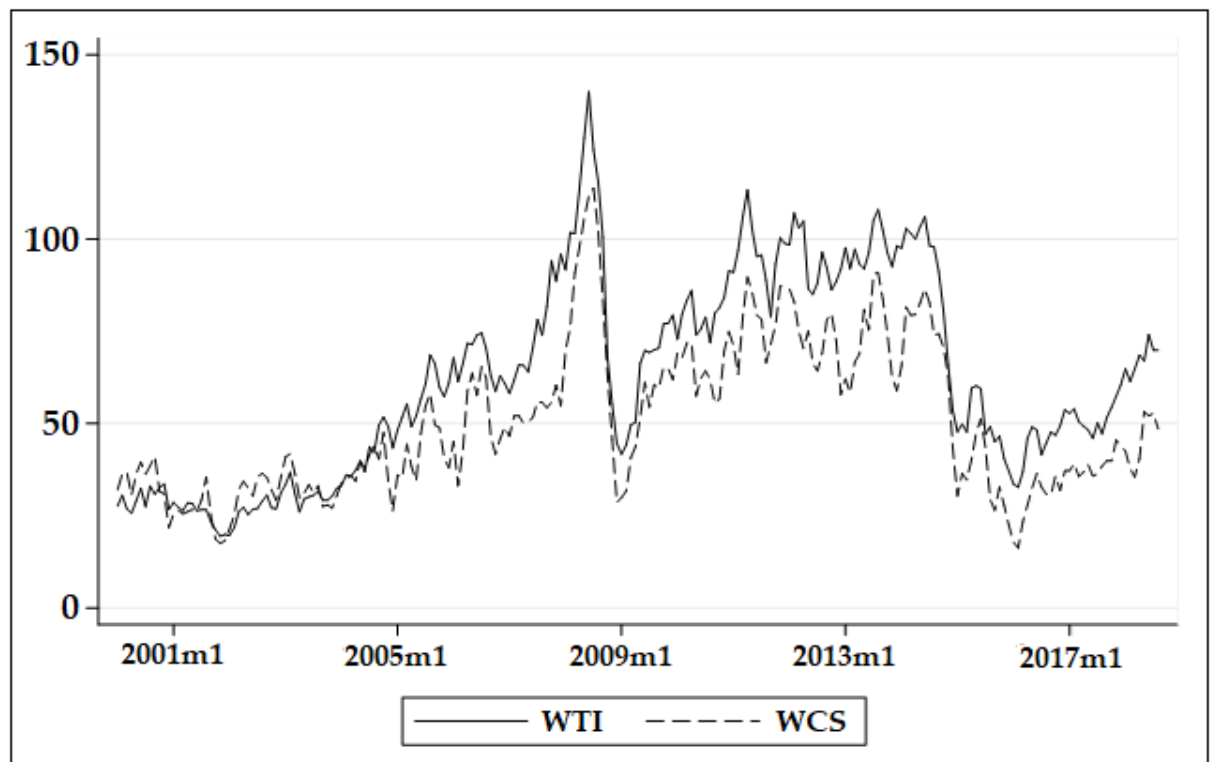
Figure 1. West Texas Intermediate (WTI) and Western Canadian Select (WCS) prices.